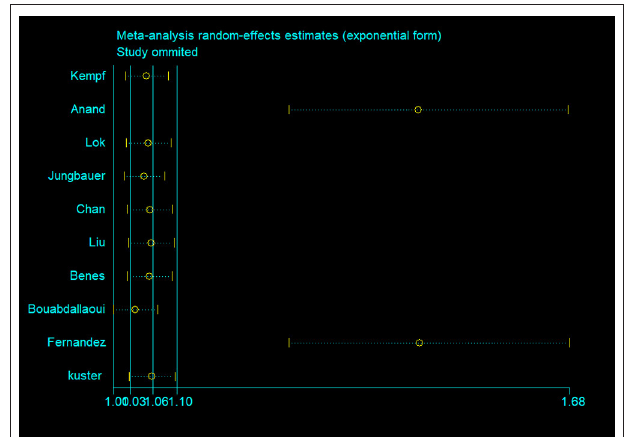
FIGURE 5 | Funnel plot after correction of publication